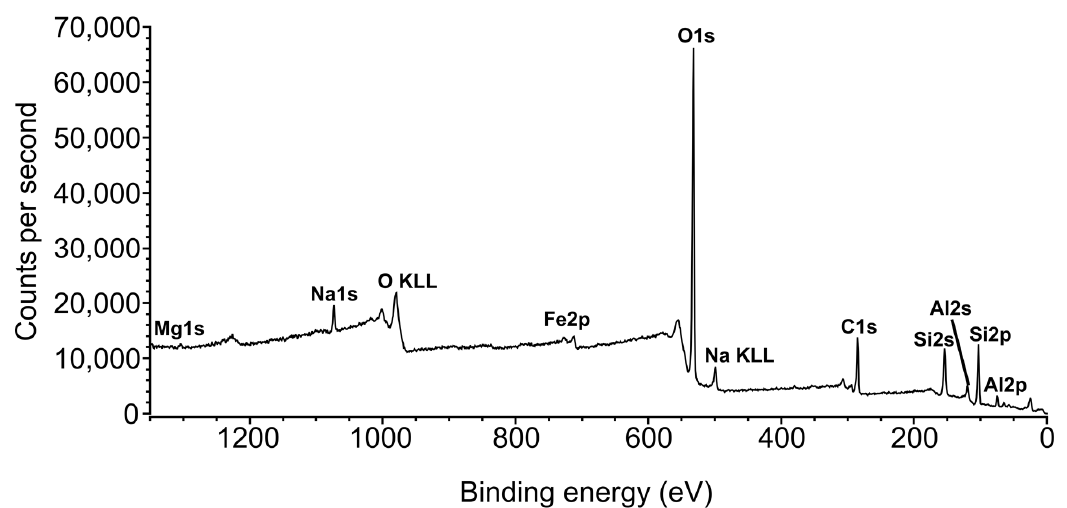
Figure 6. XPS survey scan of the Na-NZU zeolite over the range 0–1350 eV.